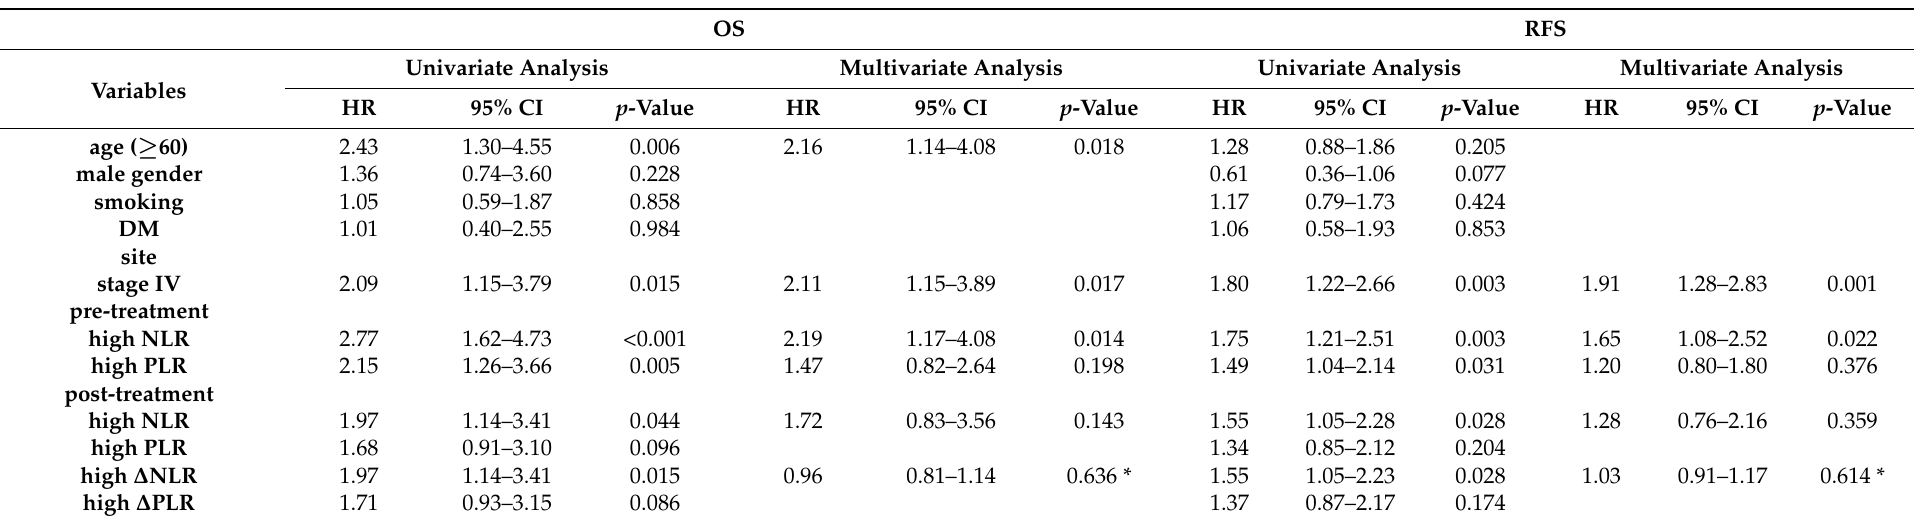
Table 3. Univariate and multivariate analysis for